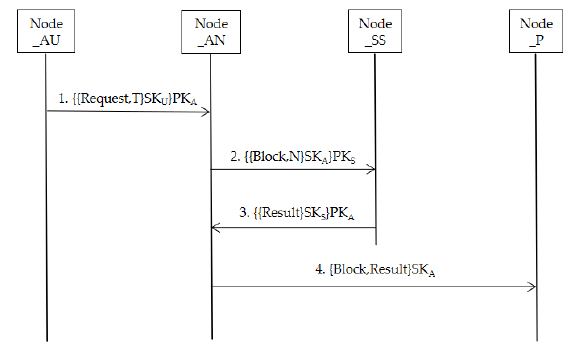
Figure 9. Consensus protocol.